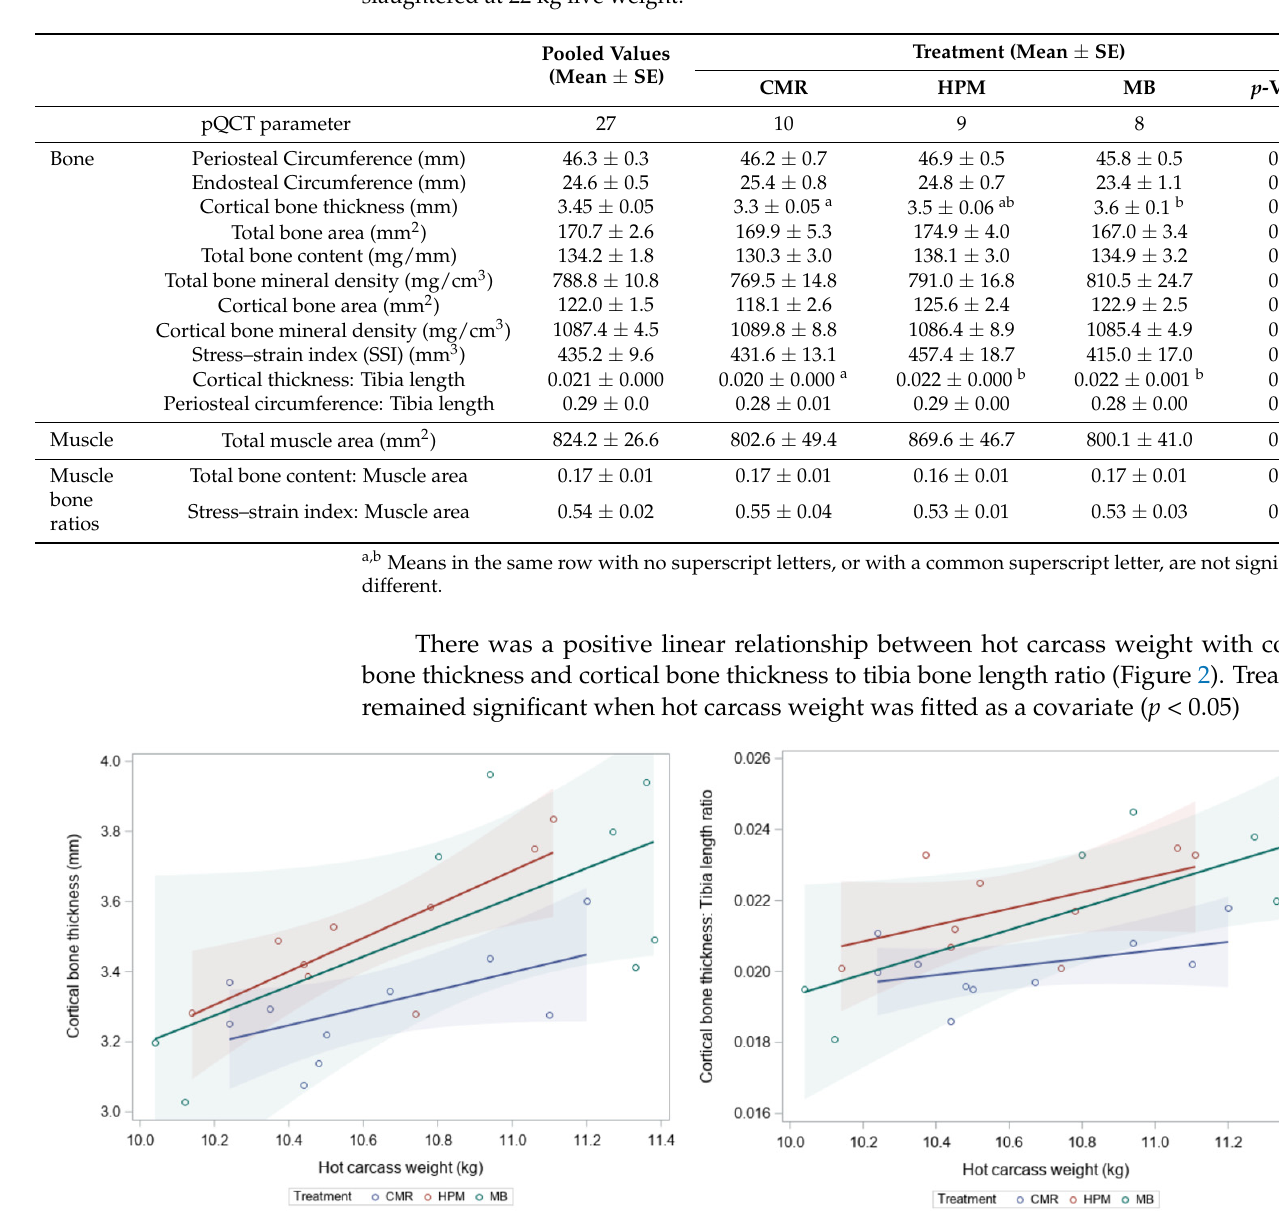
Figure 2. Scatterplot with regression lines and 95% confidence intervals for cortical bone thickness (left) and the ratio of cortical bone thickness to tibial bone length (right) in the mid-diaphysis against hot carcass weight of lambs fed commercial milk replacer (blue), high protein milk (red), milk blend (green) diets and slaughtered at 22 kg live weight.